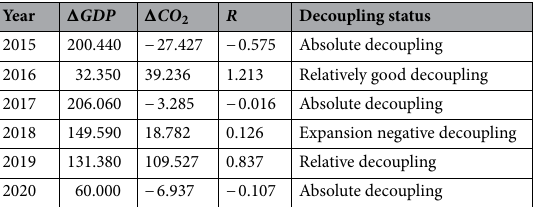
Table 8. Carbon Emissions and Economic Decoupling Index for the Yellow River Delta 2015–2020 ( GDP : hundred million yuan, CO 2 : ten thousand tons).